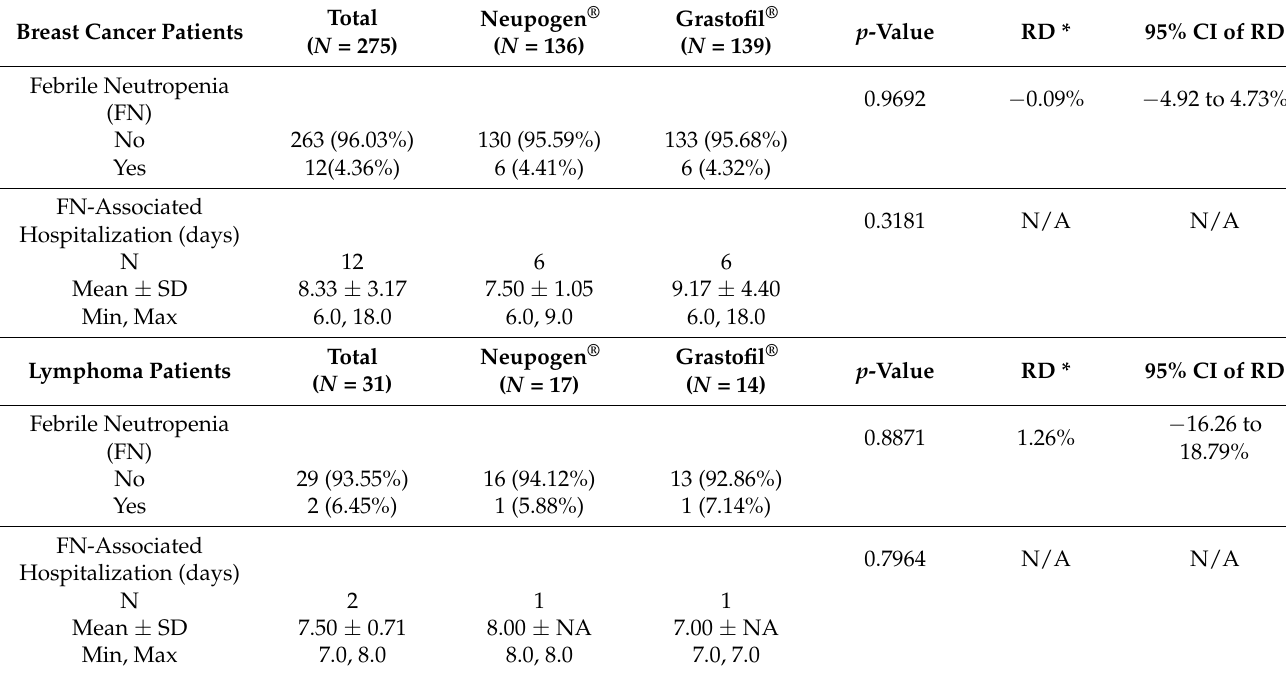
Table 4. First Cycle Febrile Neutropenia Outcomes.